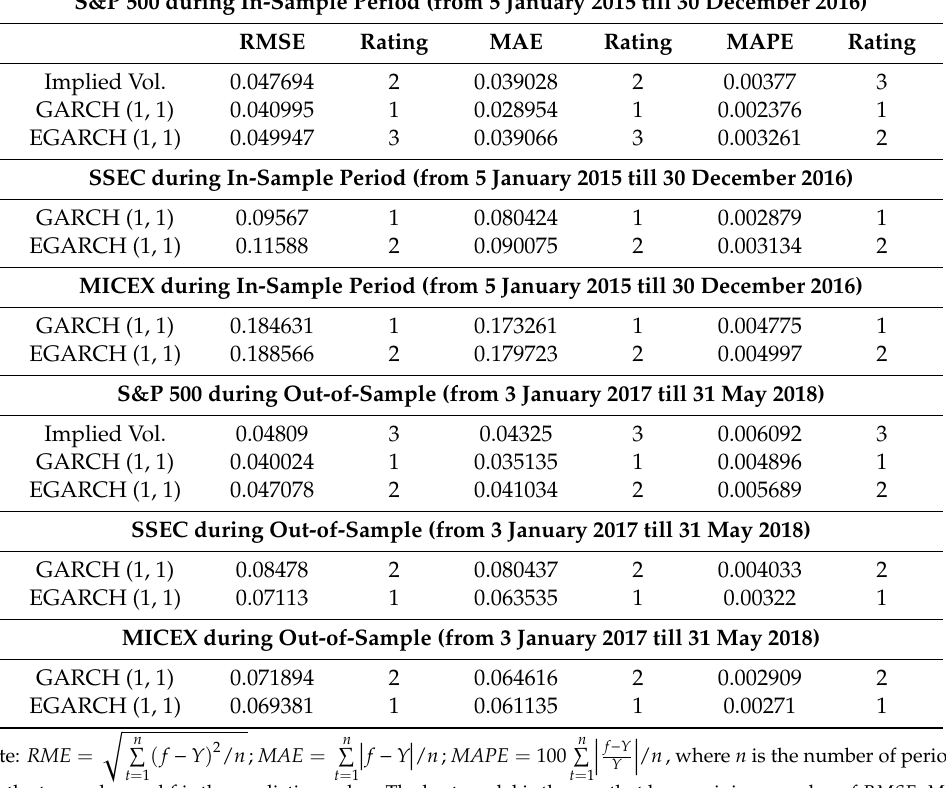
Table 6. In-Sample Period Error